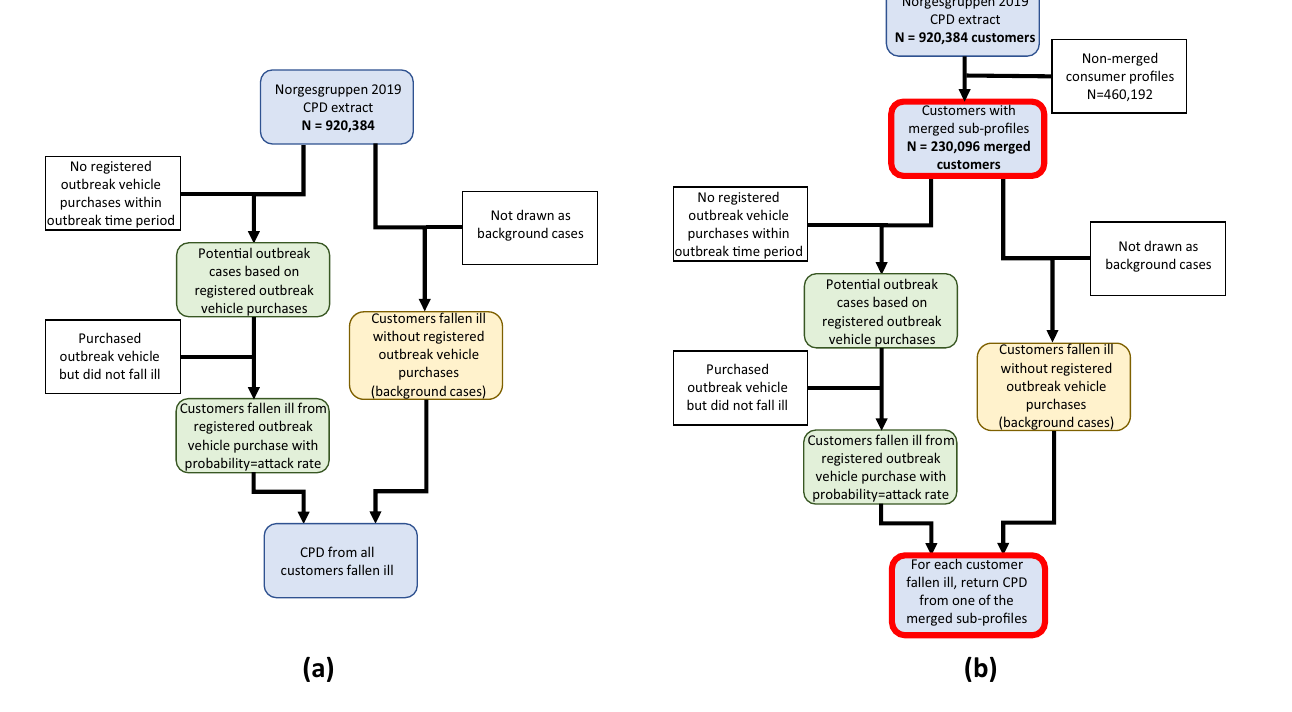
Figure 1. Flow charts of outbreak simulations. ( a ) Single-chain outbreak simulation. The left-hand chain in green shows how cases are generated from purchase history, while the right-hand chain in yellow illustrates how background cases are randomly selected. ( b ) Two-chain outbreak simulation. Modifications from the single- chain outbreak simulation highlighted in Background cases were generated differently in two scenarios. In the first scenario, we imagine the outbreak vehicle having been sold in a single supermarket chain, while in the second scenario it would be sold in two different supermarket chains, each with their own separate CPD. In the single-chain outbreak scenario, the number of background cases was generated as a proportion of the total number of cases; if the background case proportion parameter was 0.2, then 80% of cases would be purchase cases and 20% will be background cases . Customers with fewer registered purchases were also assumed to have more unrecorded consumption, and thus an increased chance of being a background case. Hence, the chance of being randomly selected as a background case was inversely proportional to the number of weeks with registered purchases for each customer (Fig. 1a, yellow boxes). For the two-chain outbreak scenario, we made two alterations (highlighted in red in Fig. 1b). First, we mod- eled customers with purchases from both supermarket chains by combining CPD profiles pairwise, where one of the sub-profiles represented CPD from supermarket chain A, and the other sub-profile represented CPD from chain B. For this, 25% of profiles registered in the dataset were randomly selected. Next, each of these profiles were matched with a different profile in the remaining dataset with the constraint that their combined profile had registered purchases in 80–120% of weeks (weeks with purchases from both chains allow for > 100%). This ensured that profiles contain a reasonable purchase record. For example, if a customer shops 60% of weeks at the primary supermarket chain, it seems likely they might shop 20–60% of weeks at a different supermarket chain. The unmatched CPD profiles were discarded in this simulation. After profile merging, outbreak simulation was performed as described above, generating purchase cases and background cases. However, instead of returning the complete purchase records of all case profiles, one of the sub- profiles was randomly selected and returned from each merged profile. This modeled a situation where we only have access to CPD from one of the two grocery chains. For comparison we ran a parallel simulation where the entire merged profile’s purchase records were returned for analysis, simulating access to CPD from both chains. Outbreak analysis. After simulating outbreaks, we used logistic regression to generate odds ratios (OR) for each purchased item. The algorithm iterated chronologically through the outbreak period, analyzing newly arisen cases in order of detection date. This approach is shown in Fig. 2. Once the number of cases exceeded five, logistic regression was initiated using item purchases as covariates. We did not attempt to solve outbreaks with less than five cases. As controls, we used the purchase histories of four randomly selected customers for each registered case. Items purchased by the recorded cases were used as regression covariates and analyzed as binomial data (1 if the covariate item was purchased by the customer, and 0 if not). Each customer’s purchases in the logistic regression were weighted by their percentage of weeks with